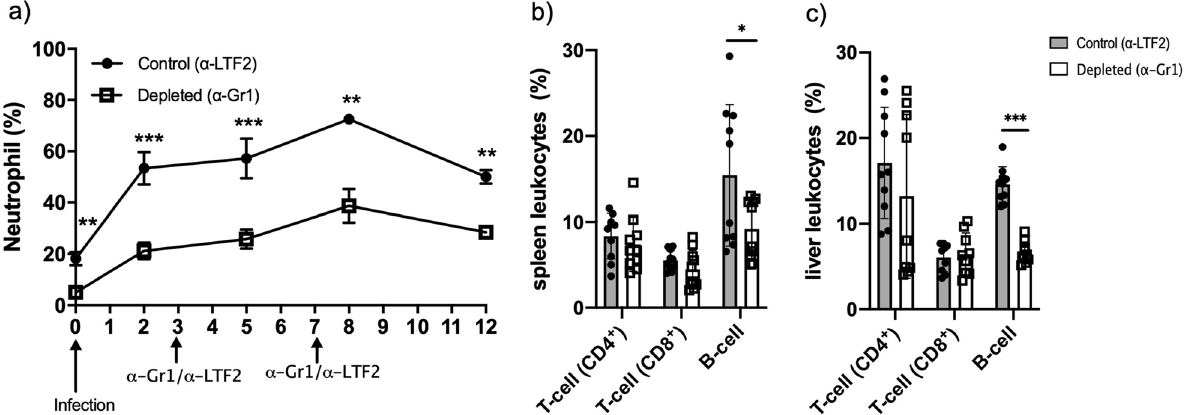
Figure 4. Neutrophil and lymphocytes analysis of isotype control and neutropenic animals after 14 days of F. pedrosoi infection: Peripheral blood neutrophil level was monitored for 12 days after F. pedrosoi infection ( a ). After 14 days of infection, T and B-cells from the spleen ( b ) and liver ( c ) were analyzed by flow cytometry according to the antibodies described in Suppl. Table 1. Results from two independent experiments (n = 4–5 animals per group and experiment) were compiled together. Values are expressed as the mean ± SD. * p < 0.05; ** p < 0.01; *** p < 0.001, two-tailed unpaired Student t